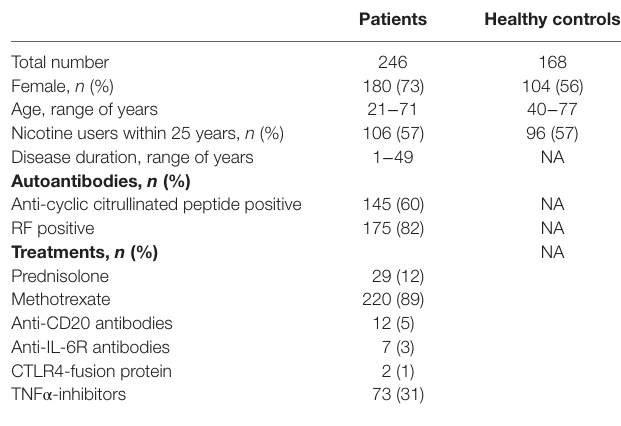
TaBle 1 | Demographic and clinical characteristics of RA patients and healthy